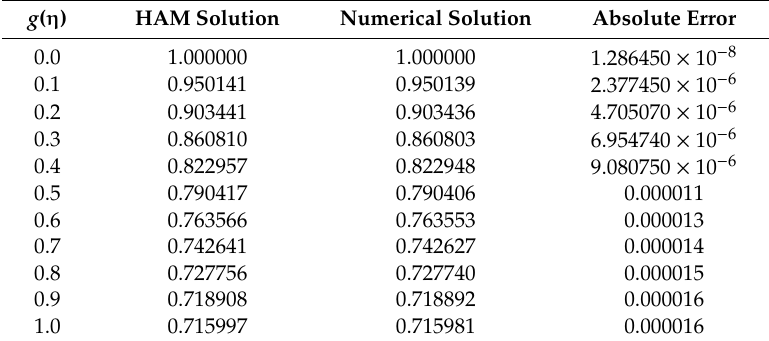
Table 3. Comparison of HAM and numerical solution for g ( η ).